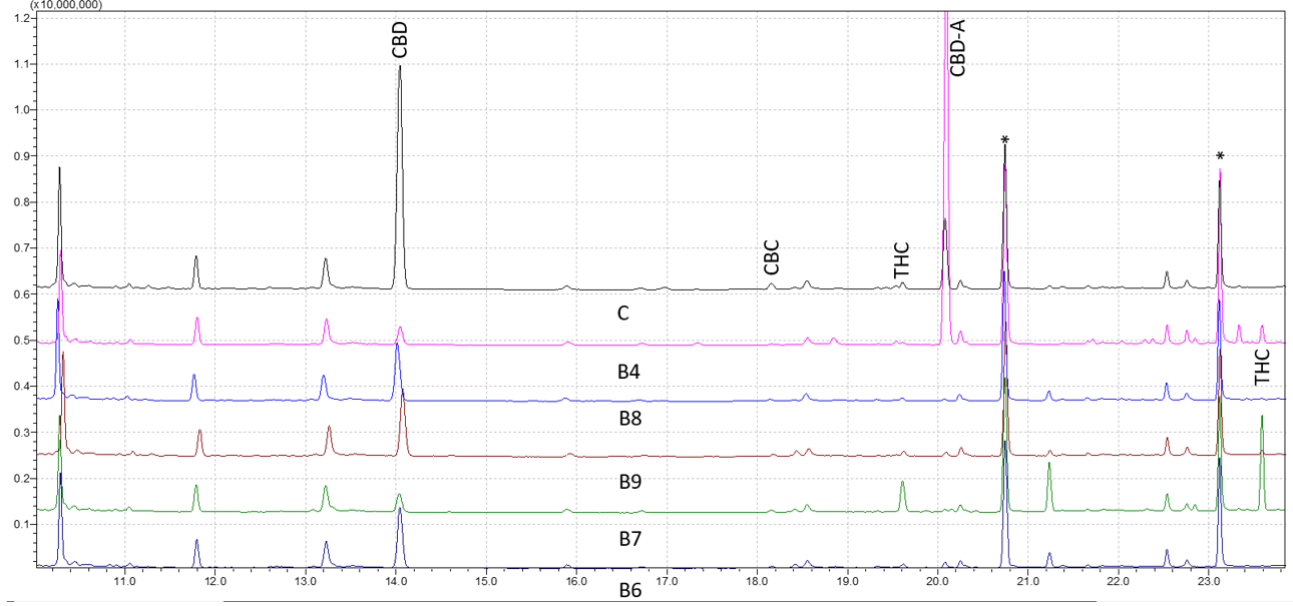
Figure 1. Chromatograms of five derivatized forensic samples analyzed through wide retention window (WRW) method by gas chromatography-mass spectrometry (GC–MS). Asterisks (*) represent trimethylsilyl esters (TMS) derivatives.